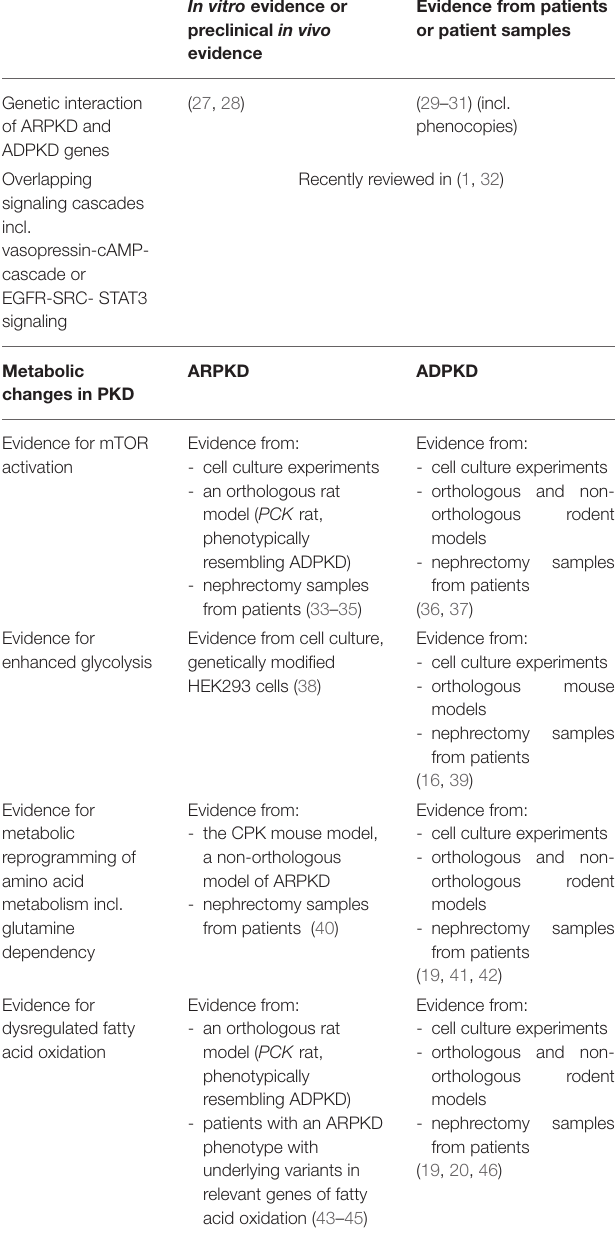
TABLE 1 | Selected evidence for overlapping dysregulated signaling cascades and metabolic changes in ARPKD and ADPKD. In vitro evidence or preclinical in